Question: According to the figure, is the described quantity increasing or decreasing?
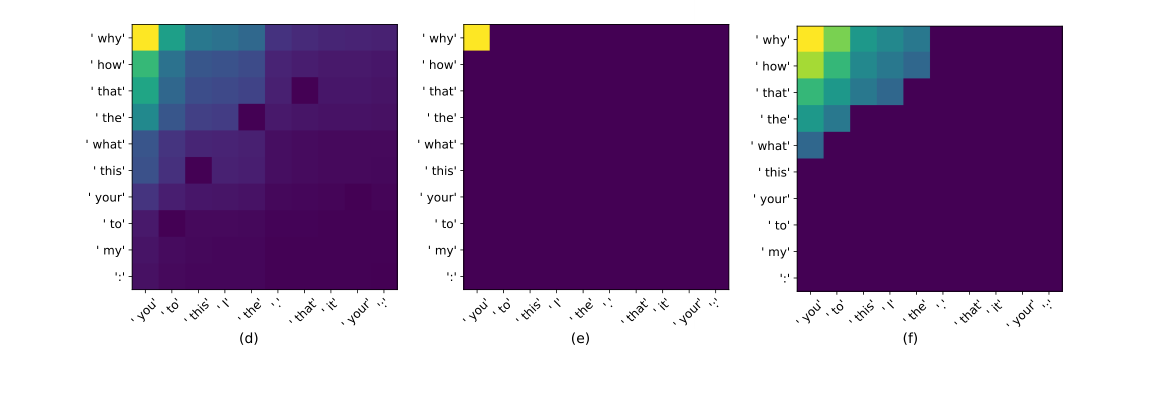
Answer: decreasing